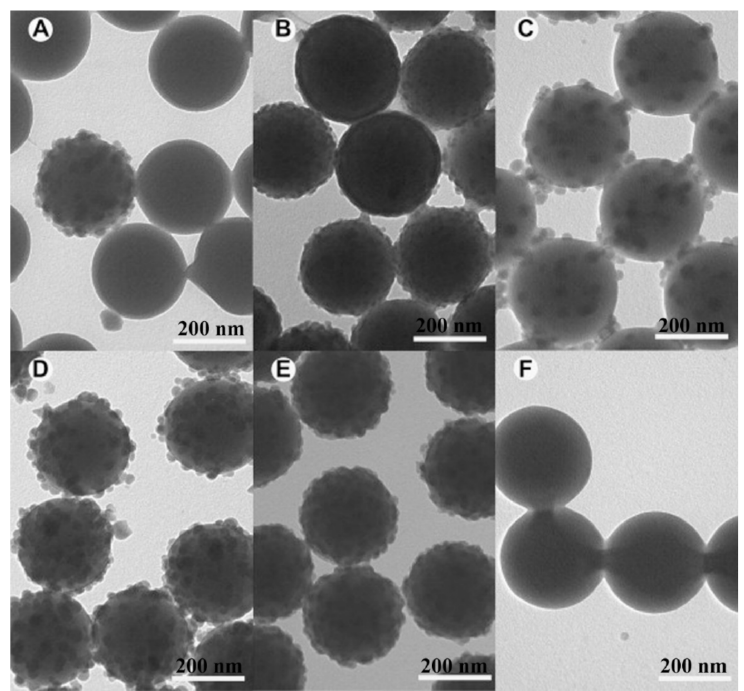
Figure 5. TEM images of PS/SiO 2 composite particles prepared with different alkali as